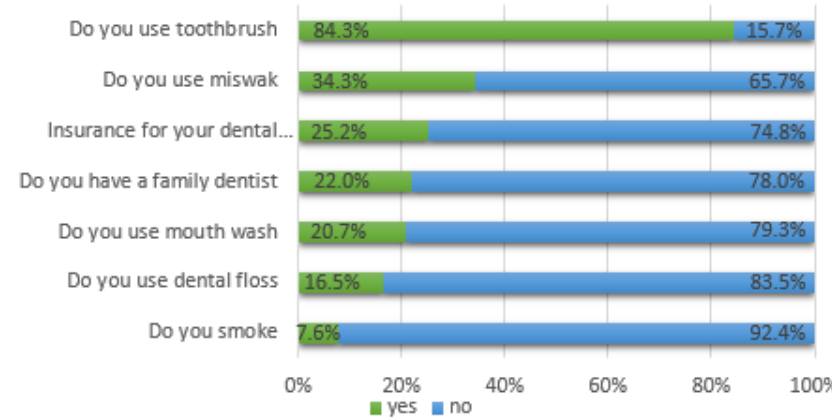
Figure 1. Oral-health-related characteristics of the study sample.